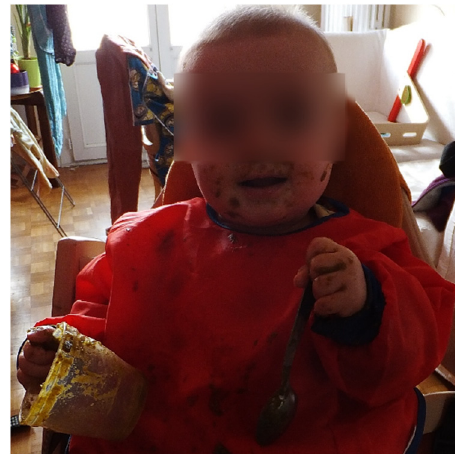
Picture 5: Daily situation—Meals and leftovers of a 7-month-old boy, Mother, high social position ( p = 0.00381; Chi2